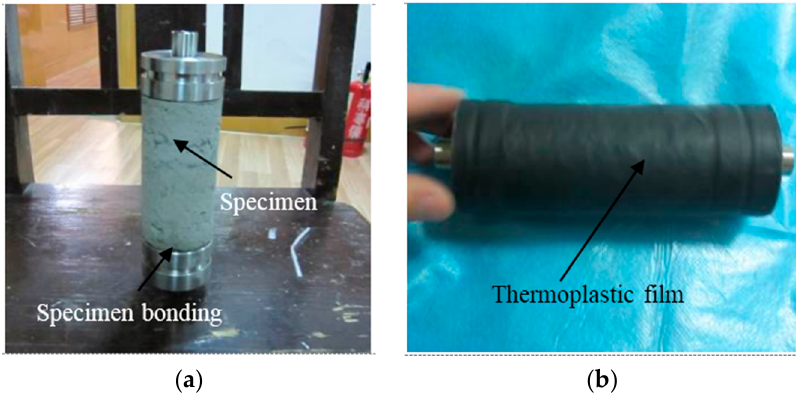
Figure 4. Test sample preparation. ( a ) The specimen bonding; and ( b ) the sample to be tested.